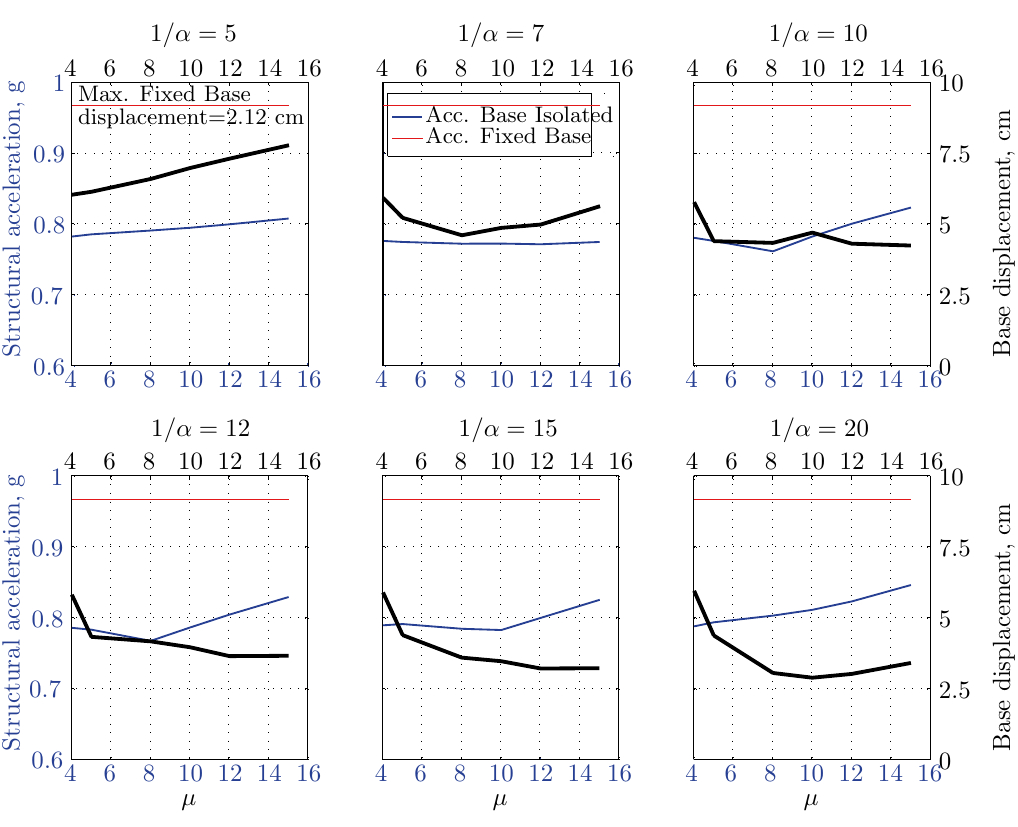
Figure 26. Peak responses of BI-structures subjected to Landers 1992 (Lucerne